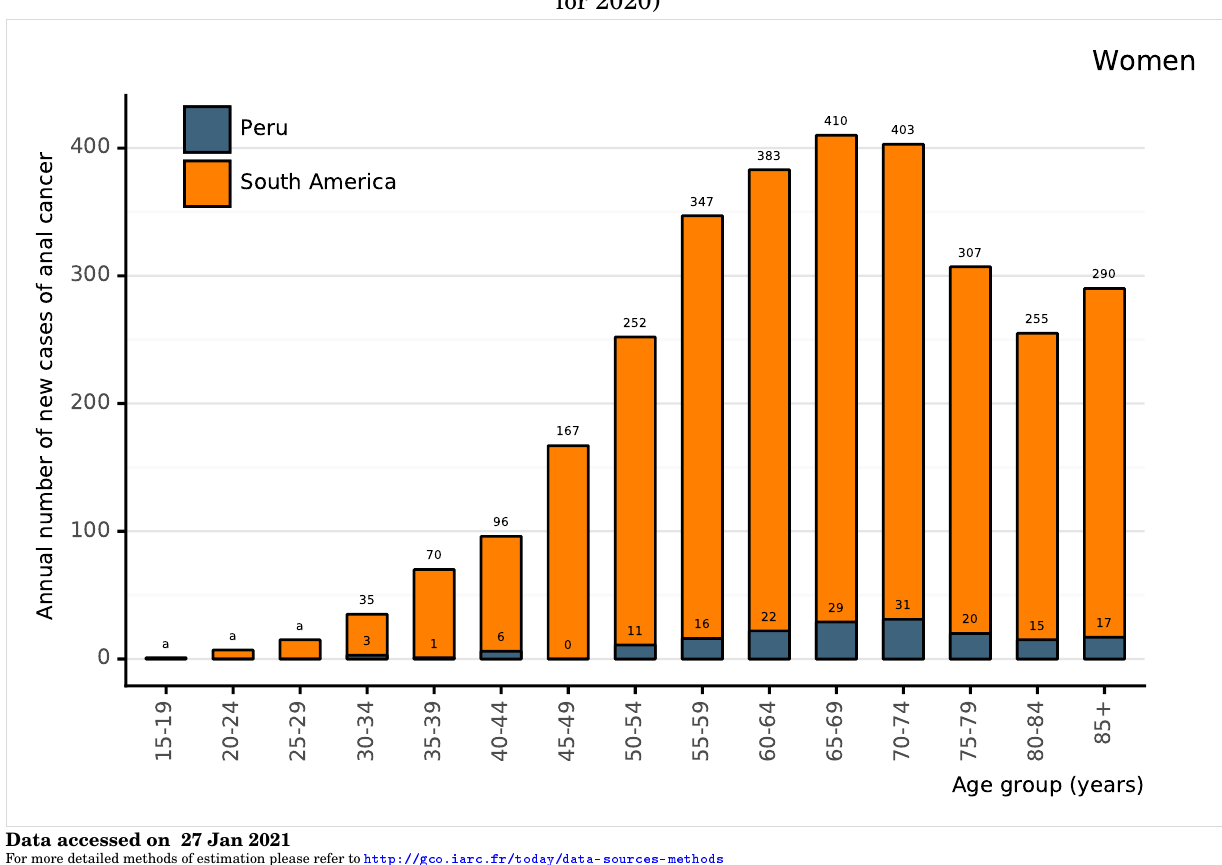
Figure 78: Annual number of new cases of anal cancer among women by age group in Peru